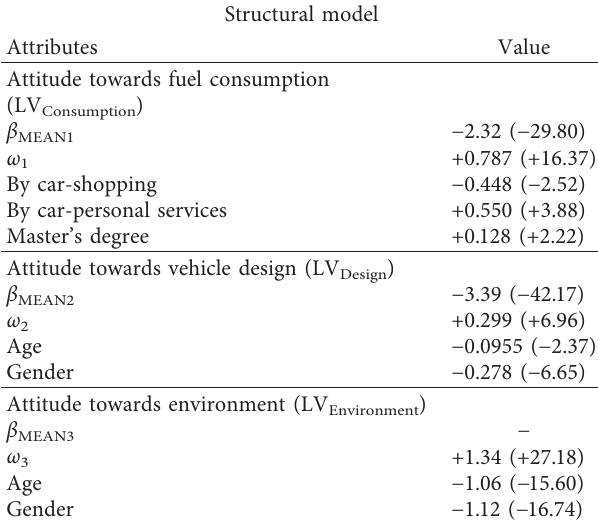
Table 10: Estimation results for structural models of HCM. Structural